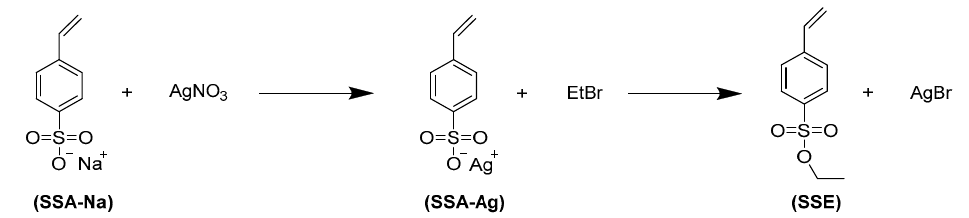
Figure 1. Reaction scheme for synthesis of styrene sulfonic acid ethyl ester.